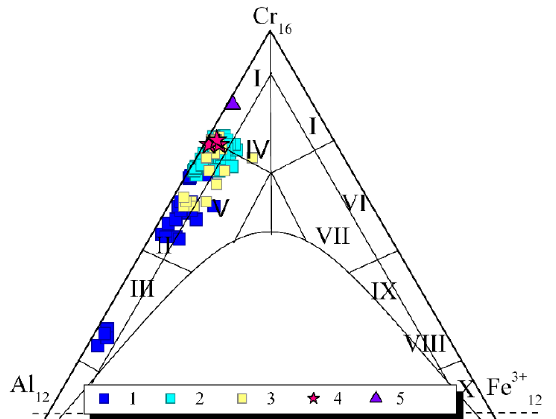
Figure 6. Classification diagram of chrome spinels from the chromitites of Ulan-Sar’dag, based on the structural formula of